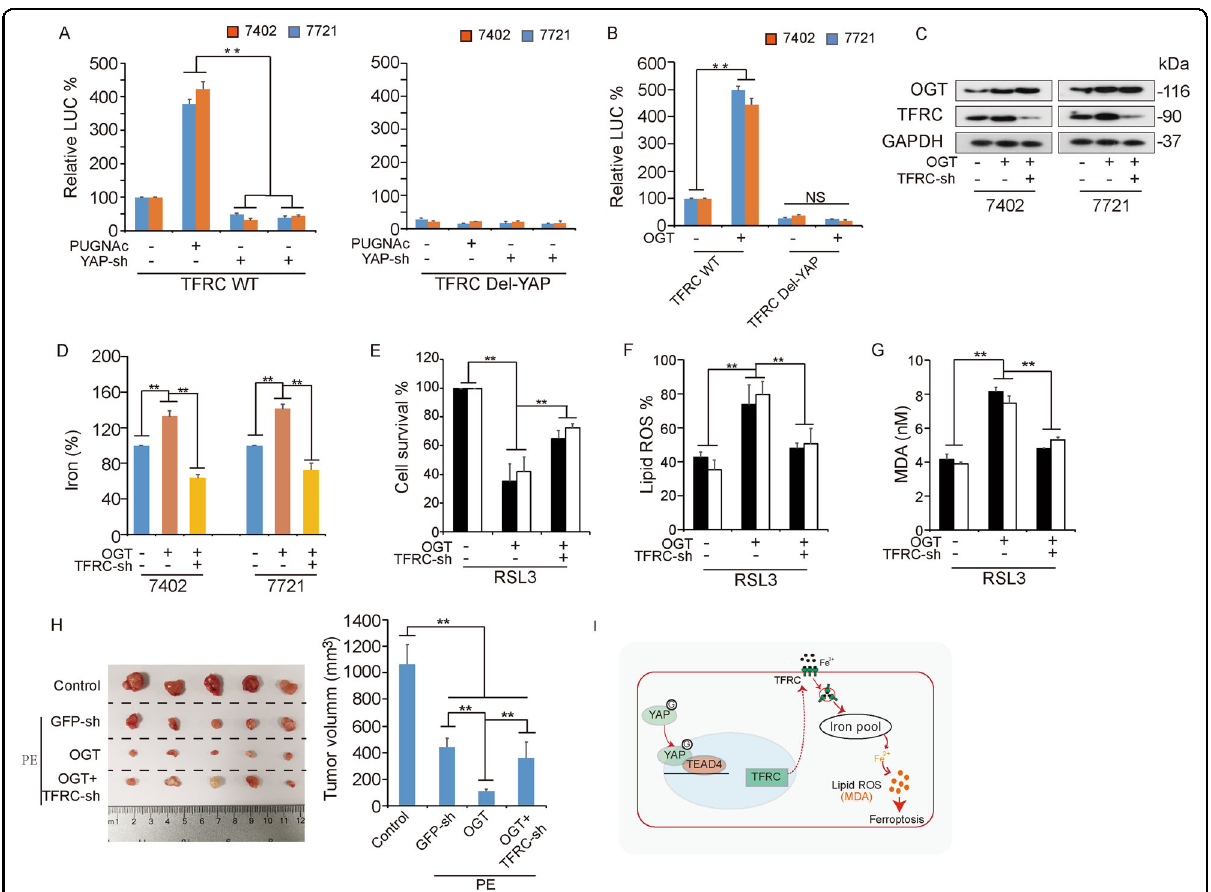
Fig. 6 O-GlcNAcylation enhances ferroptosis sensitivity by regulating TFRC. A The luciferase activity of reporters containing wild-type TFRC and Del-YAP was measured in Bel-7402 and SMMC-7721 cells with or without YAP knockdown and PUGNAc treatment. B The luciferase activity of the reporters containing TFRC and Del-YAP was measured in Bel-7402 and SMMC-7721 cells with OGT overexpression. C – G OGT was overexpressed in Bel-7402 and SMMC-7721 cells with simultaneous TFRC knockdown ( C ). The iron concentration in cells treated as indicated was determined ( D ). Ferroptotic events in cells treated as indicated were evaluated: cell death ( E ), lipid ROS production ( F ), and MDA production ( G ). H A xenograft assay was performed using Bel-7402 cells treated as indicated with or without piperazine erastin treatment. I Schematic abstract of the possible mechanism by which O-GlcNAcylation promotes ferroptosis sensitivity via the YAP/TFRC pathway in HCC